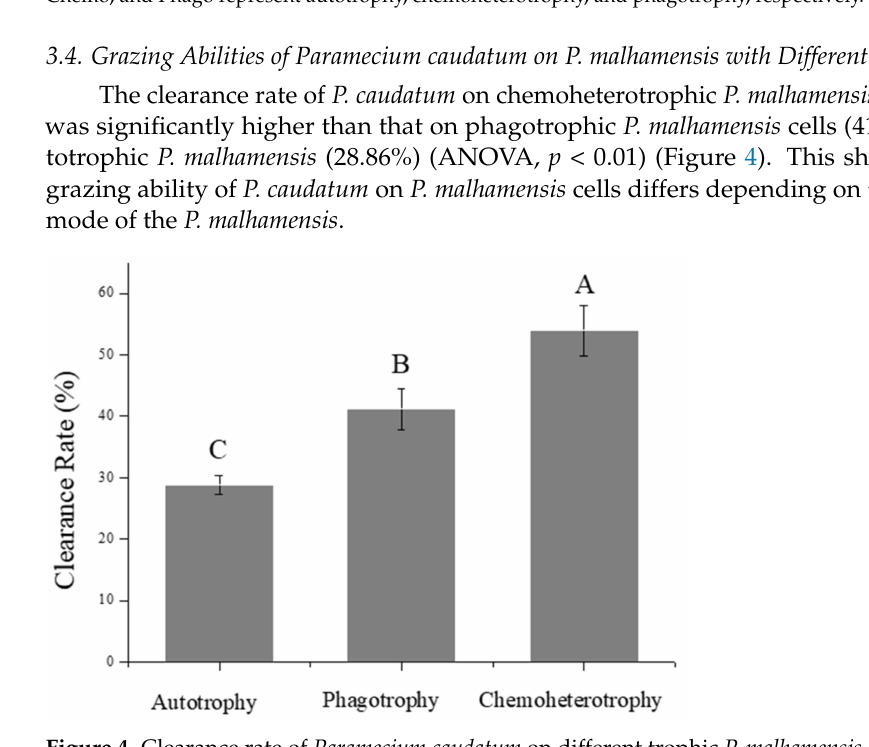
Figure 4. Clearance rate of Paramecium caudatum on different trophic P. malhamensis cells. Significant differences are indicated by different uppercase letters (one-way ANOVA, p < 0.01). Error bars indicate the standard deviation. n =